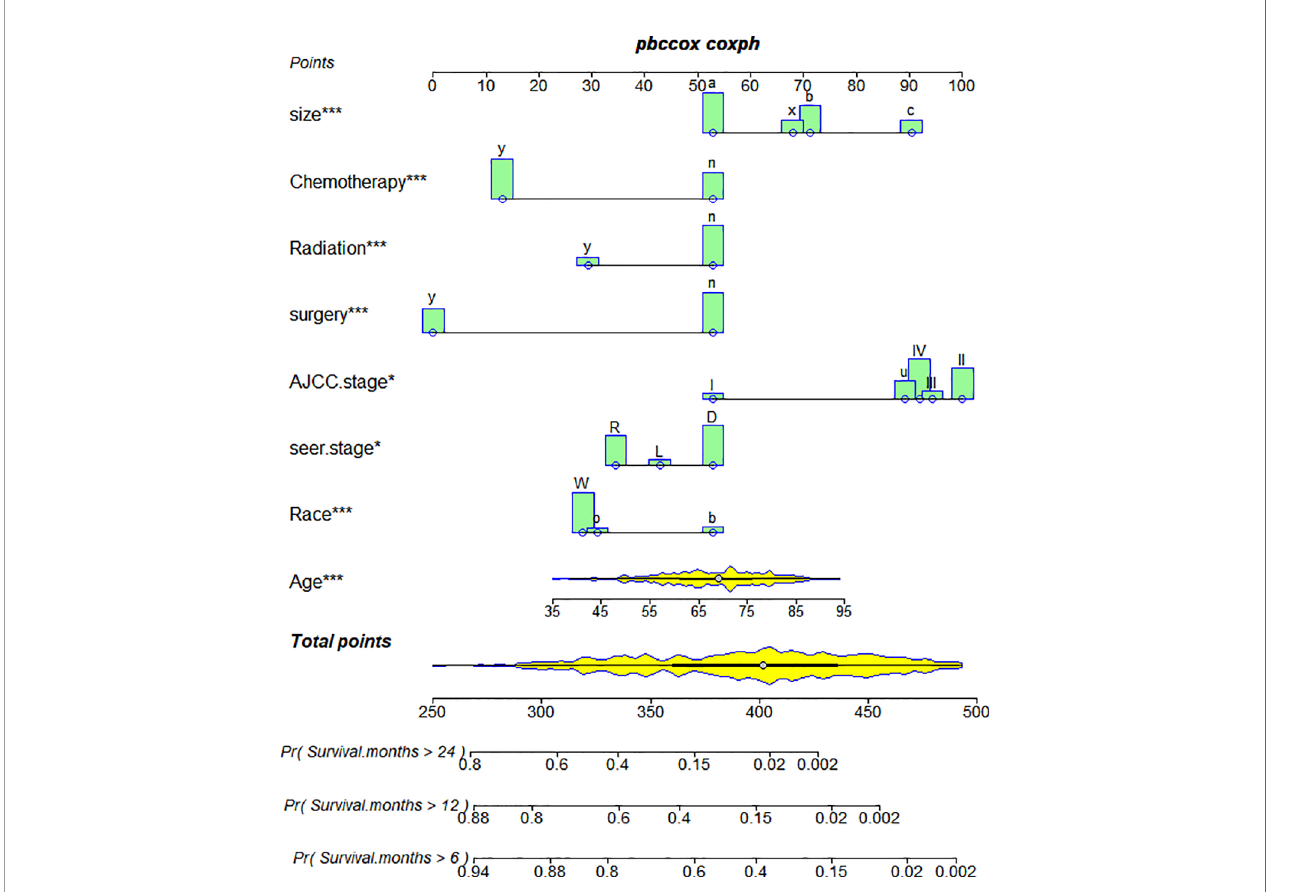
FIGURE 7 | Nomogram of ASCP. *P<0.05 for independent prognostic factors screened in the multivariate cox regression analysis of ASCP prognosis. ***P<0.01 of independent prognostic factors screened in the multivariate cox regression analysis of ASCP prognosis. They can re fl ect the in fl uence of the independent prognostic factor on the prognosis of patients, and “ *** ” is more strongly correlated with the prognosis of patients than “ * ”